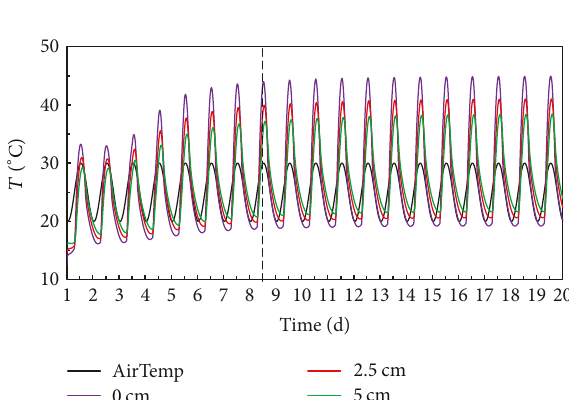
Figure 5: Simulated temporal variations of air temperature and soil temperatures at depths of 0, 2.5, and 5cm during the soil